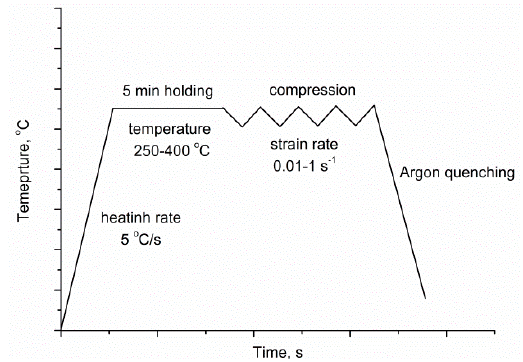
Figure 1. The experimental scheme for the hot simulation.